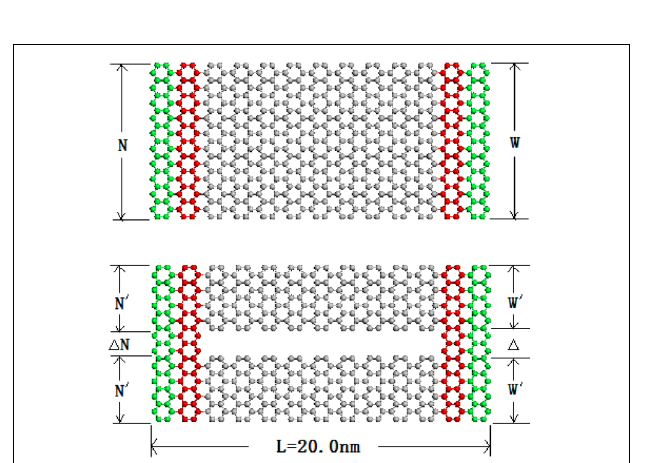
FIGURE 4 | Schematic picture of the whole GNR and “comb” GNR. The last layers of atoms at the two ends (in green) are fixed, and the atoms (in red) next to the fixed layers are placed in thermostats. The width of each branch in the comb GNR is W ’, with W = 2 × W (cid:4) + (cid:2) .